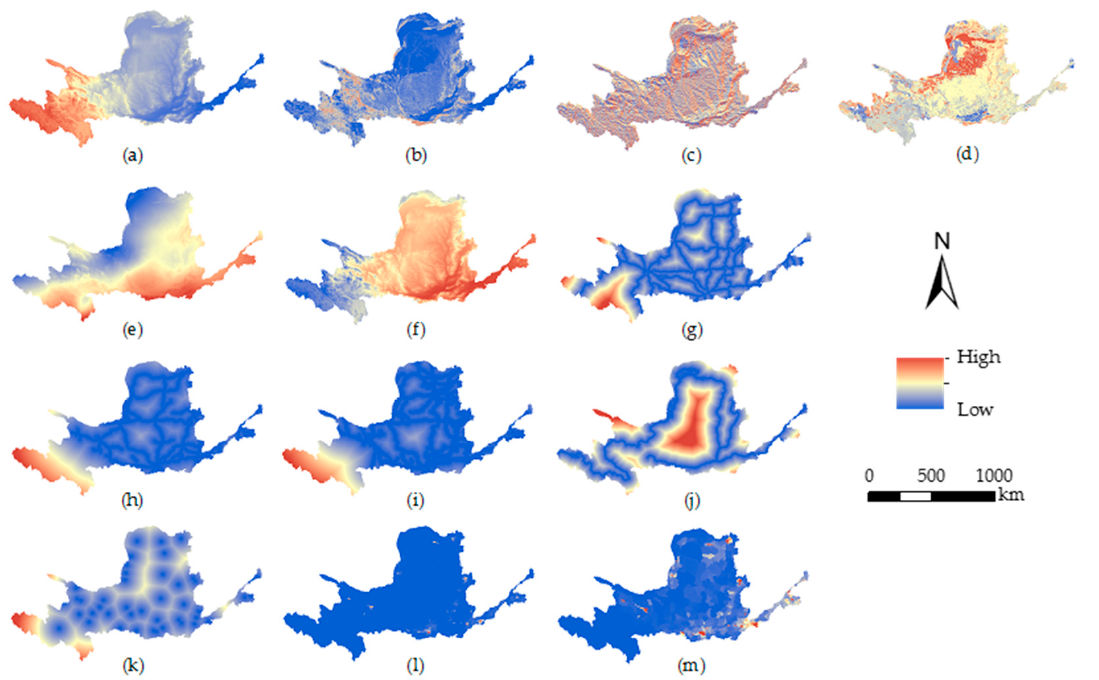
Figure 2. The main driving factors of land use change in Yellow River Basin: ( a ) elevation (m); ( b ) slope(degree); ( c ) aspect, in positive degrees from 0 to 359.9, measured clockwise from north; ( d ) soil sand content (%); ( e ) average annual precipitation (mm); ( f ) average annual temperature (°C); ( g ) distance to highway; ( h ) distance to motorway (m); ( i ) distance to railway (m); ( j ) distance to river (m); ( k ) distance to city (m); ( l ) population per km 2 ; and ( m ) GDP per km 2 . Table 1. Input data for the improved Logistic-CA-Markov model and InVEST model. Data